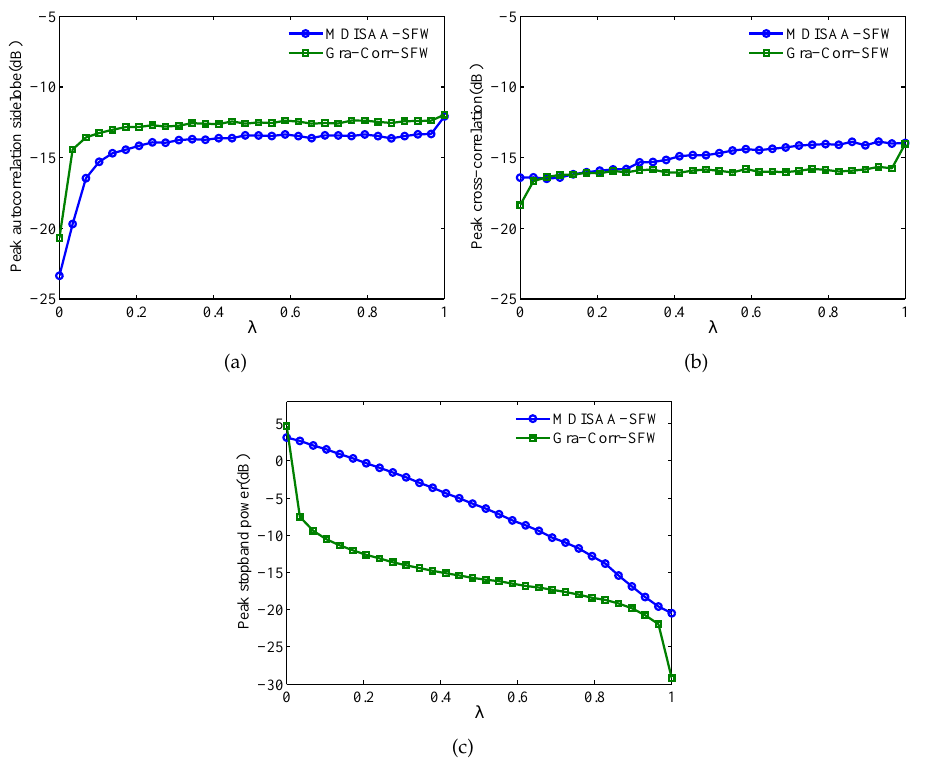
Figure 9. The comparison of P ac , P cc and P sp between MDISAA-SFW and Gra-Corr-SFW versus λ from 0–1. ( a ) P ac ; ( b ) P cc ; ( c ) P sp ( M = 3, N =